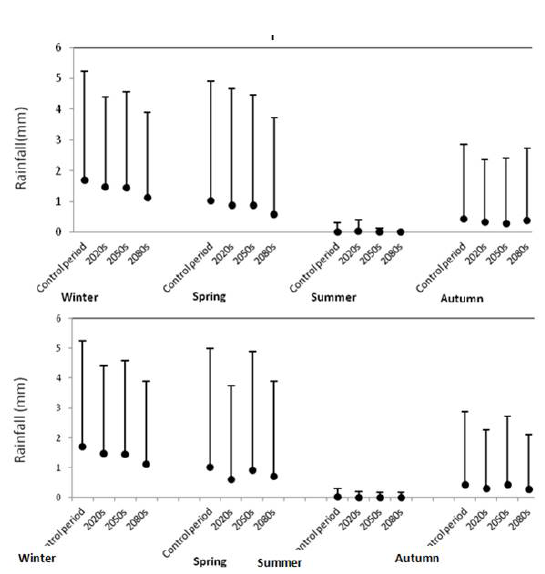
months and can be up to 96% and 58% as in June of the A2 and March of the B2 scenarios, respectively.